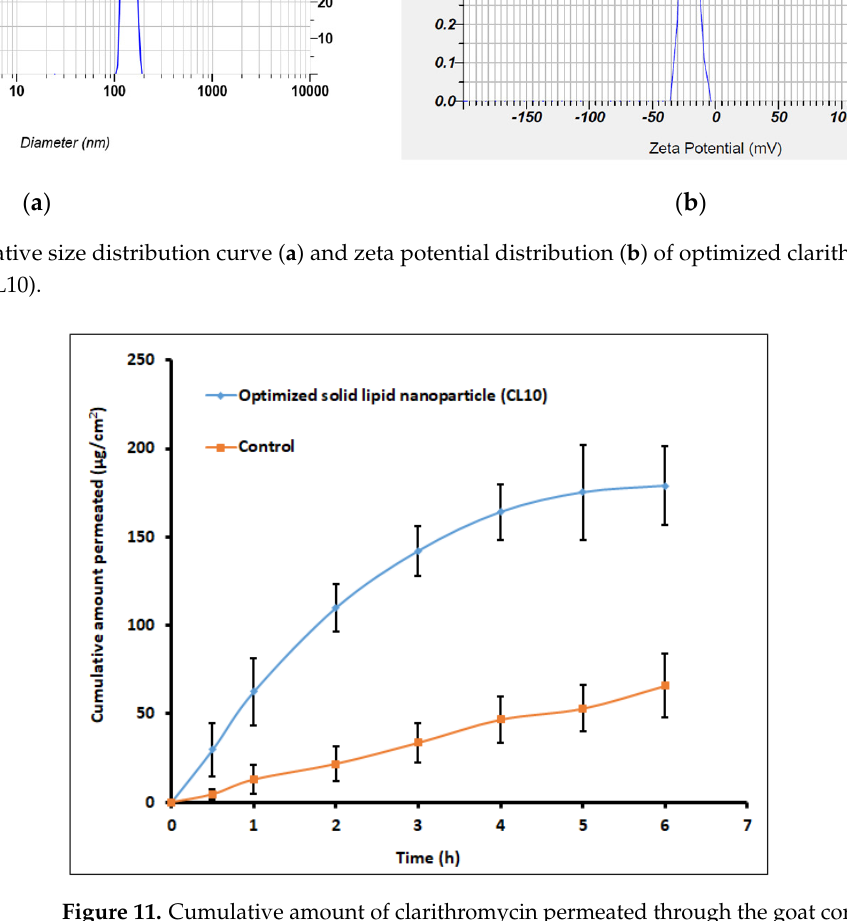
Figure 12. Surface morphology of optimized clarithromycin solid lipid nanoparticles (CL10). Red arrow indicates the diameter of nanoparticle. 3.9. Ocular Compatibility Eye irritation score from individual rabbits was added to obtain the total irritation score, which was subsequently divided by the total number of eyes used for the ocular irritancy test to obtain the final eye irritation score. The calculated eye irritation score in